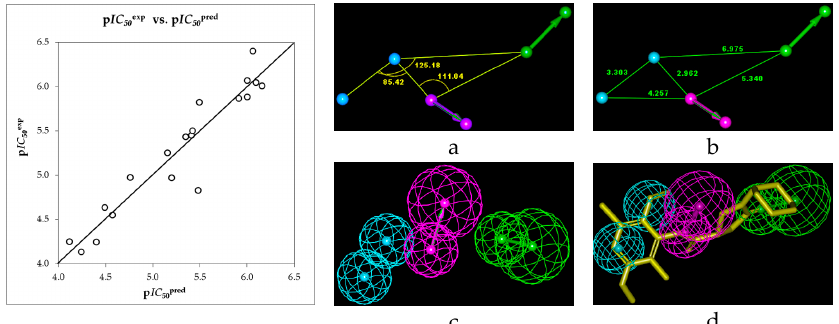
Figure 7. Coordinates ( a , b ), features ( c ) and mapping ( d ) of the InhA inhibitor pharmacophore with the best fit hit 21-2-H-6-4 (yellow). The correlation plot of experimental vs. predicted inhibitory activity is displayed at the left. The features are colored blue for hydrophobic aliphatic (HYd), green for hydrogen-bond acceptor (HBA) and purple for hydrogen-bond donor (HBD). The arrows represent the projection for donor and acceptor features.